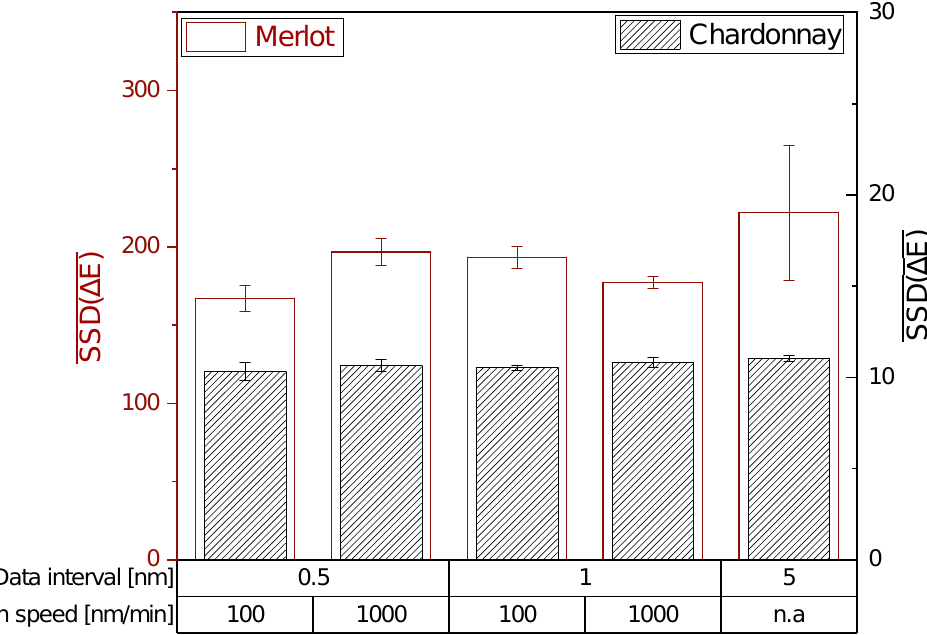
Figure 5. Influence of the photometer settings data interval and scan speed on the CIE L*a*b* coordinates on the Varian Cary 100 double beam photometer. The mean sum of squared deviation is shown with error bars (SD; n = 3; α =